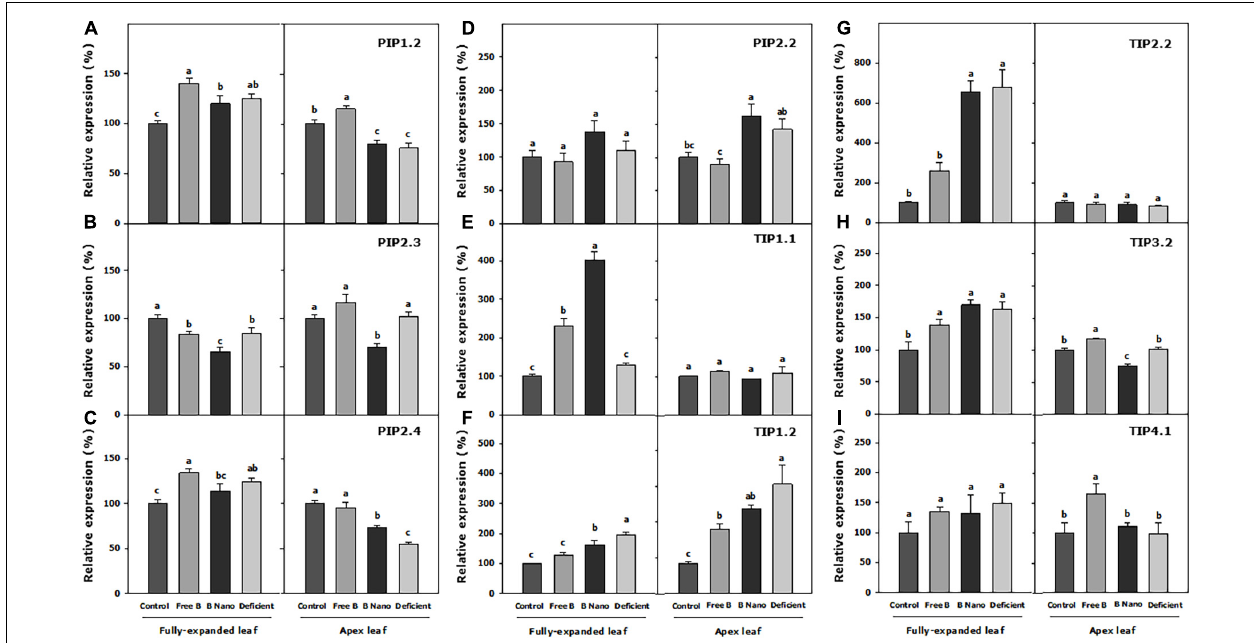
FIGURE 6 | Expression analysis of (A) PIP1.2, (B) PIP2.3, (C) PIP2.4, (D) PIP2.2, (E) TIP1.1, (F) TIP1.2, (G) TIP2.2, (H) TIP3.2, and (I) TIP4.1 P. dulcis AQPs at S1. Statistical analysis was performed for separating different tissues, fully expanded, and the youngest leaves. Normalized expression levels were rescaled and presented as r.e. with respect to the control. B Nano, Nanoencapsulated B. The values are the means ± SE of four individual analyses. Columns with different letters differ significantly according to Duncan’s test ( p <